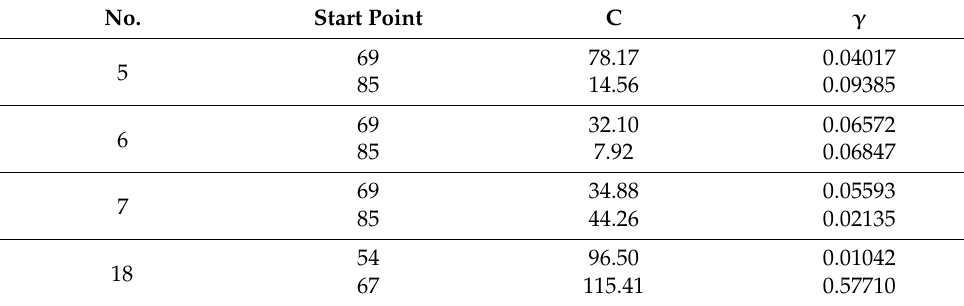
Table 3. The results of PSO for optimizing the SVR parameters.